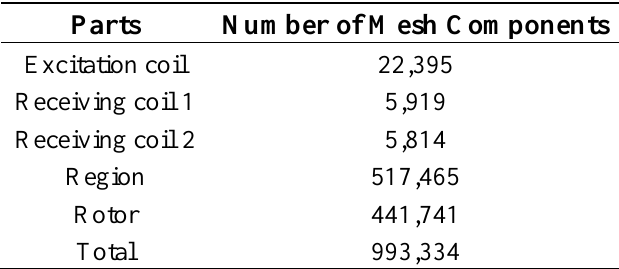
Table 1. Mesh operation information of studied sensor in different components.